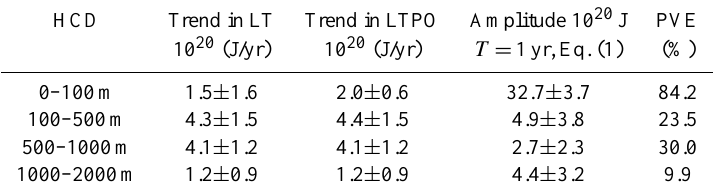
Table 3. HCD for the whole basin at different layers; the uncertainty is at the 95% confidence level. HCD Trend in LT